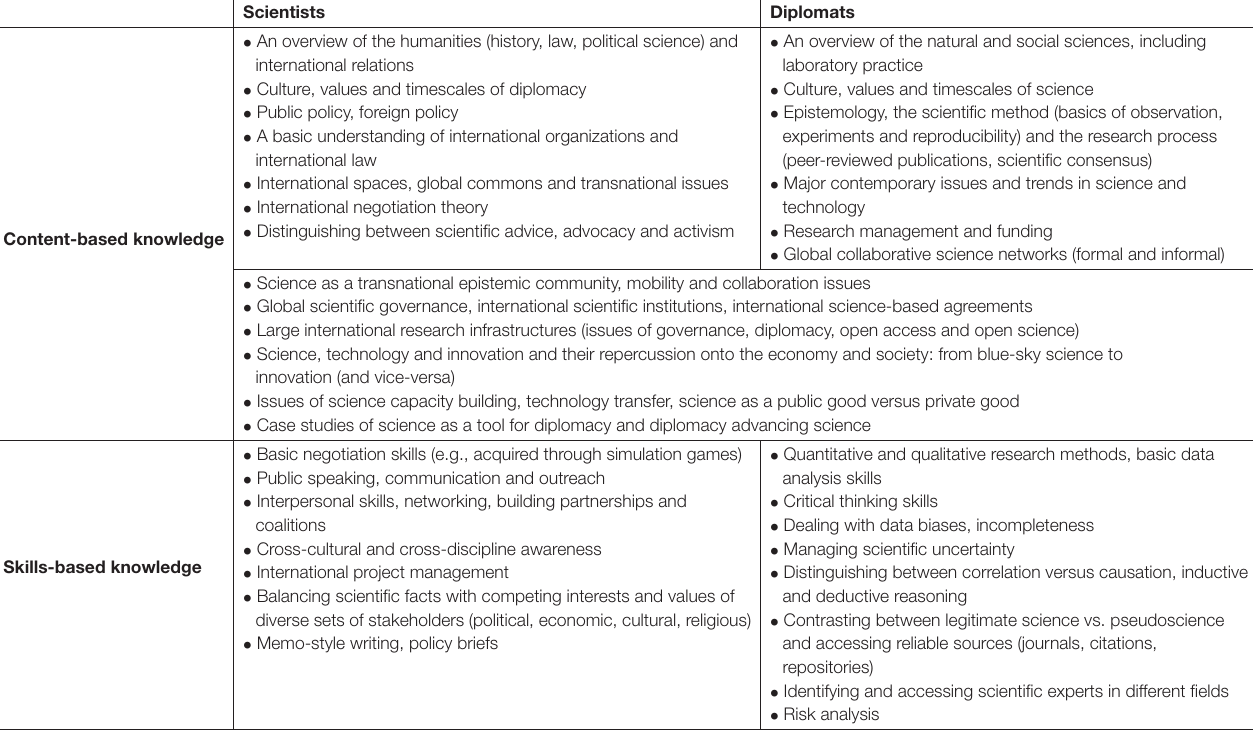
TABLE 1 | A framework for science diplomacy education (content and skills-based) for scientists and diplomats.